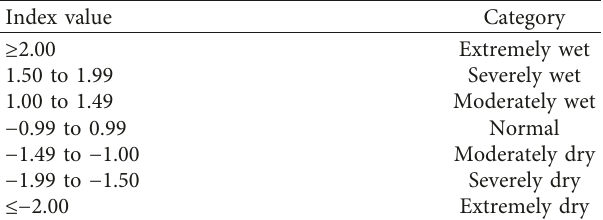
Table 2: Standardized Precipitation Index (SPI)